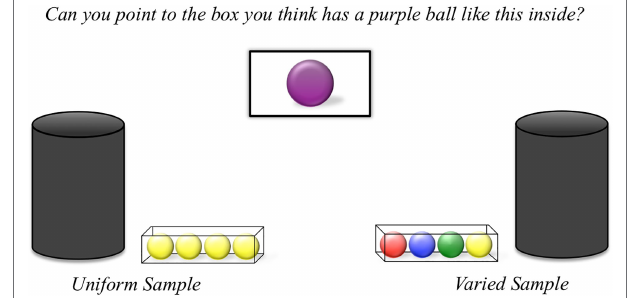
FIGURE 1 | Stimuli presented to participants at test. Note that in Experiments 2 and 3, the third ball of the varied-sample was purple, rather than green, and the novel-ball was green, rather than purple. This was to ensure the colors would be equally distinct across different